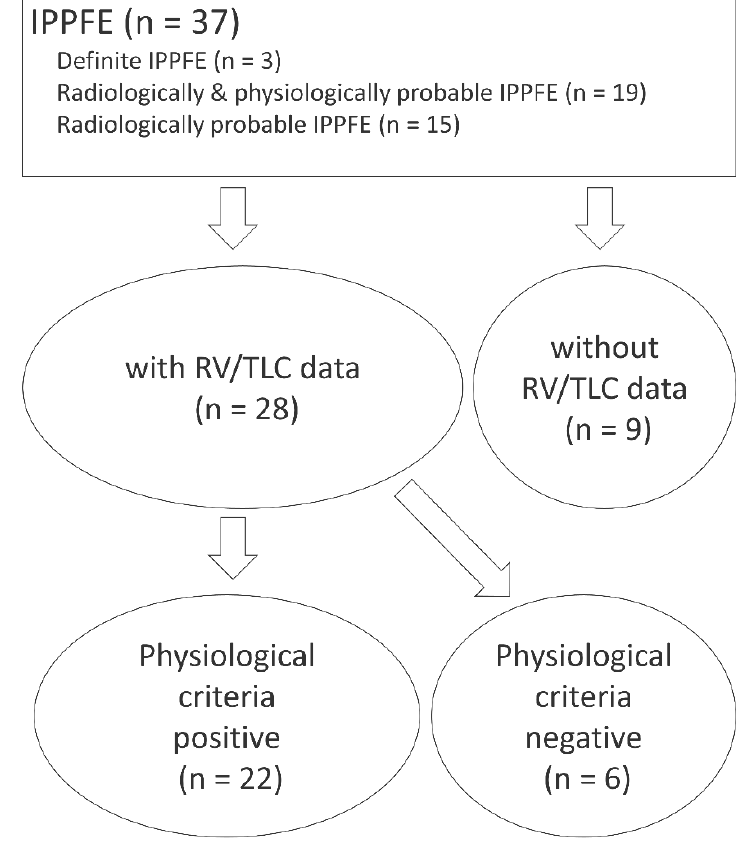
Figure 2. A schematic diagram of the enrolled idiopathic pleuroparenchymal fibroelastosis (IPPFE) patients. RV, residual volume; TLC, total lung capacity .